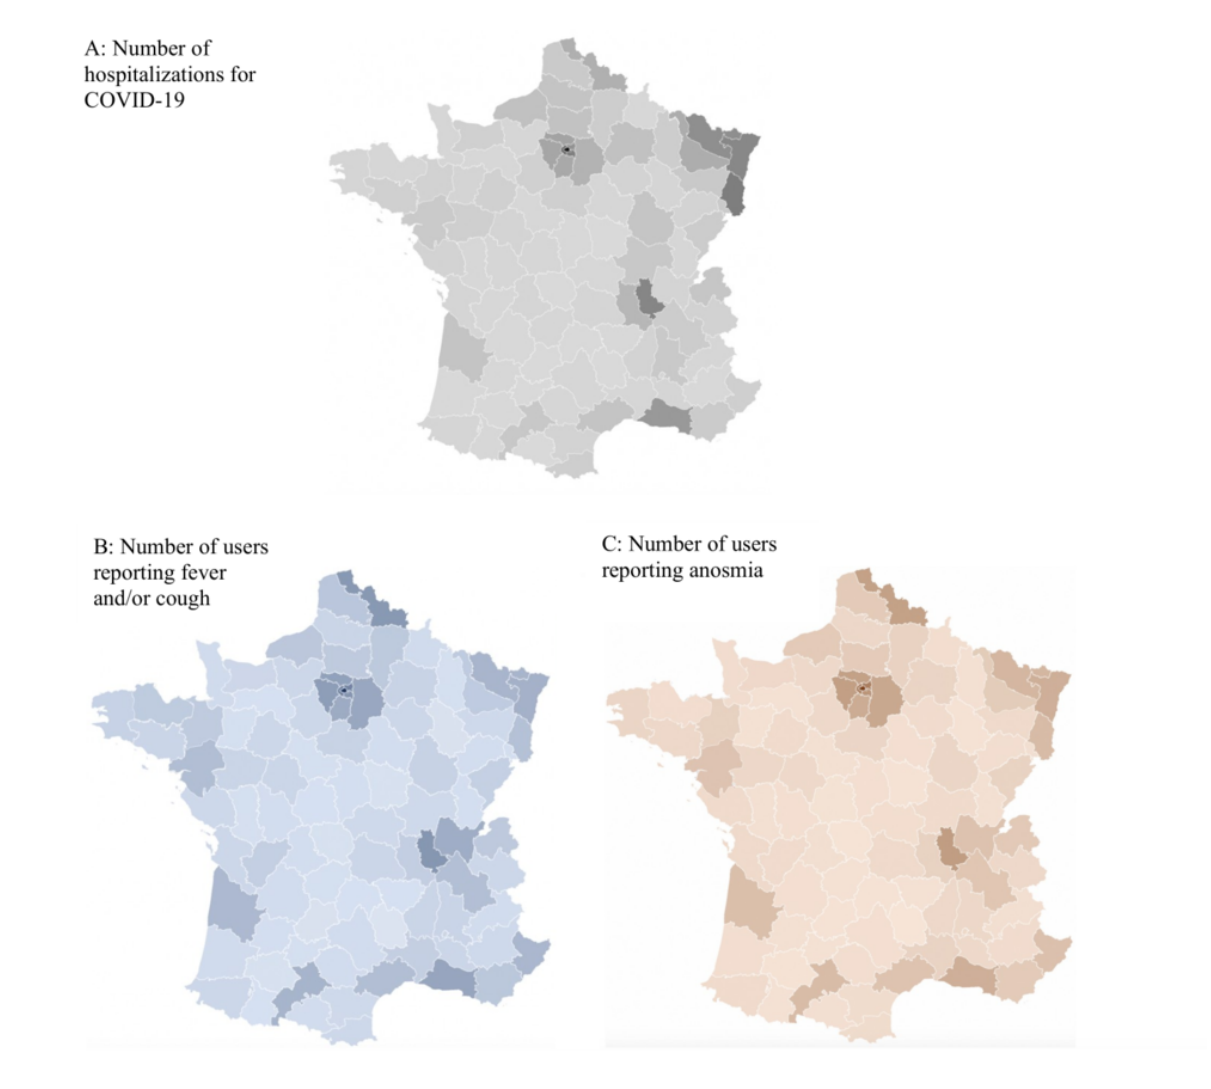
Figure 2. Maps displaying the correlation between fever and/or cough and anosmia with hospitalizations for COVID-19. (A) The cumulative number of hospitalized COVID-19–positive patients in France on March 29, 2020. (B) Fever and/or cough reported by users via the application; cumulative amount in French counties from March 17-29, 2020: 3,799,535 respondents (828,952 with fever and 1,515,557 with cough). (C) Anosmia reported by users; cumulative number from March 21-29, 2020: 325,910 positive